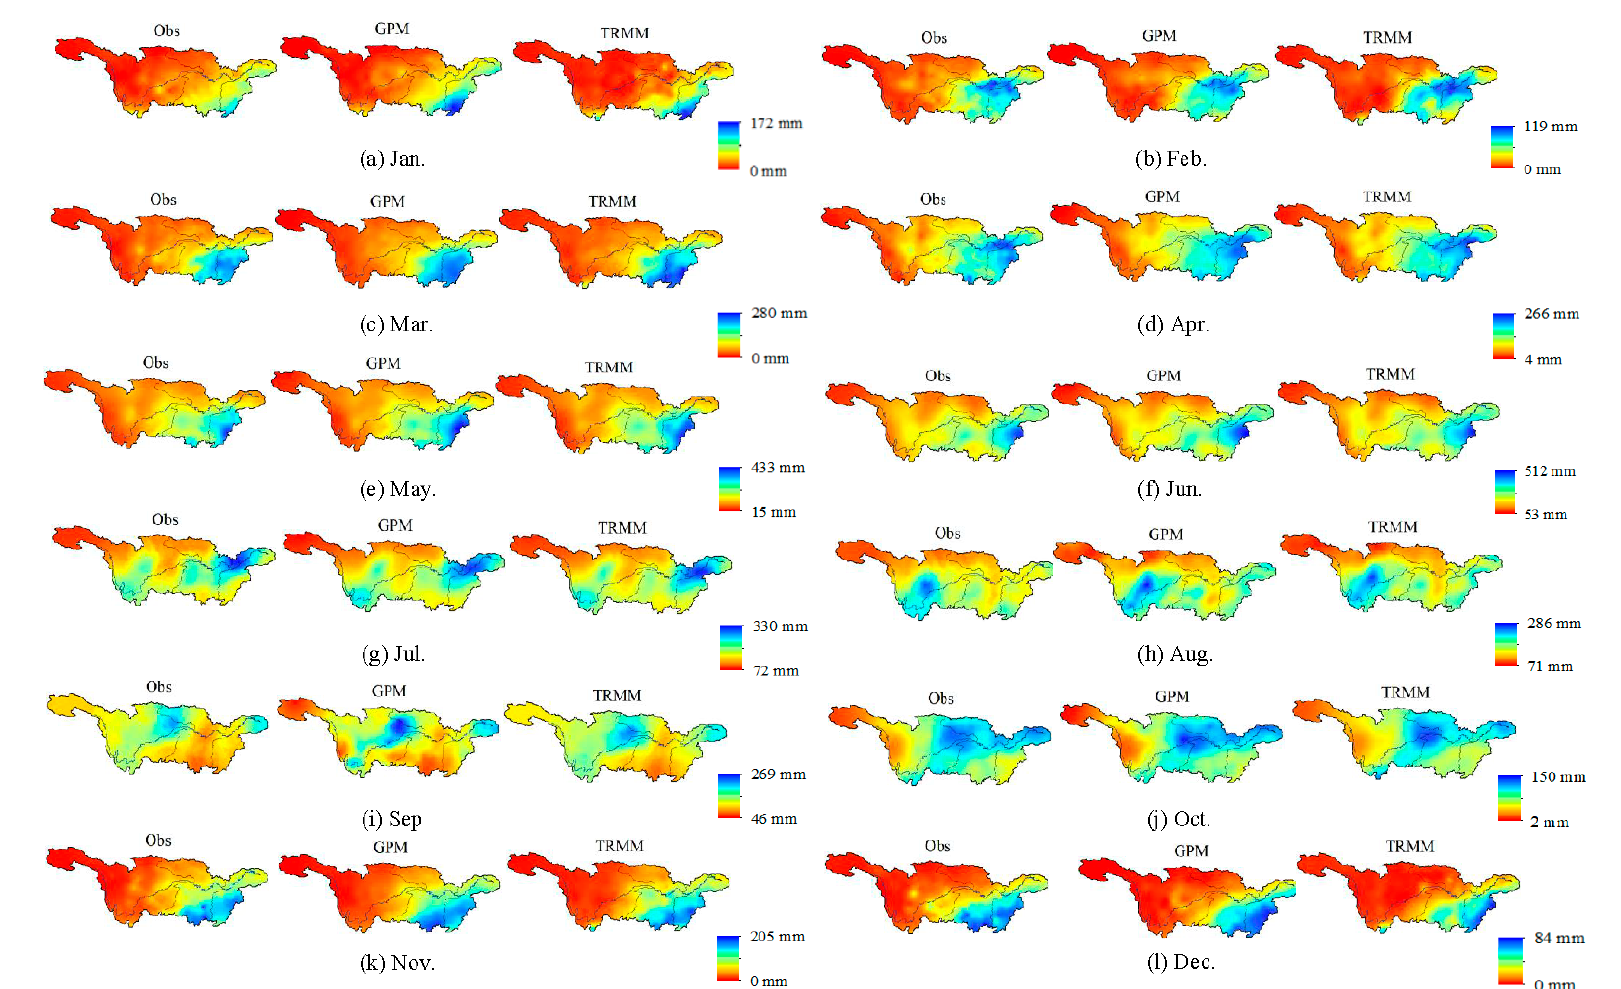
Figure 5. Spatial distribution of monthly average precipitation of rain gauge stations, GPM IMERG v5 and TRMM 3B42 v7 during April 2014–December 2017. ( a ): January; ( b ): February; ( c ): March; ( d ): April; ( e ): May; ( f ): June; ( g ): July; ( h ): August; ( i ): Sepember; ( j ): October; ( k ): November; ( l ):